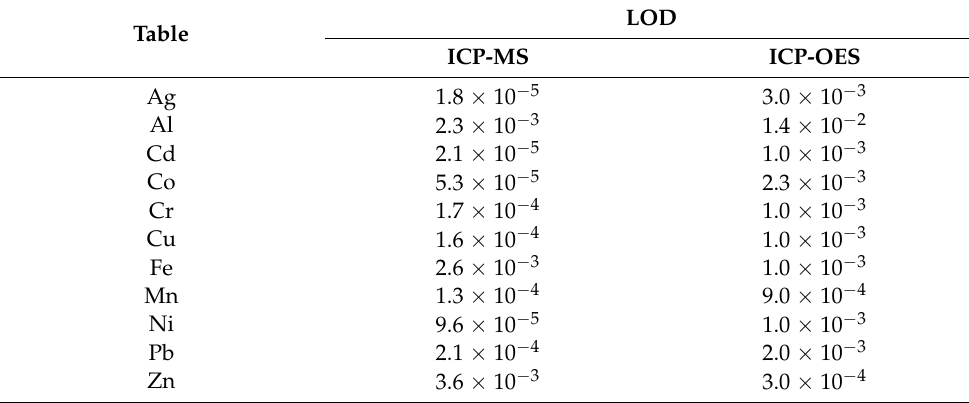
Table 2. Comparison of limit of detection (LOD) levels [ppm] for trace elements (TEs) from selected